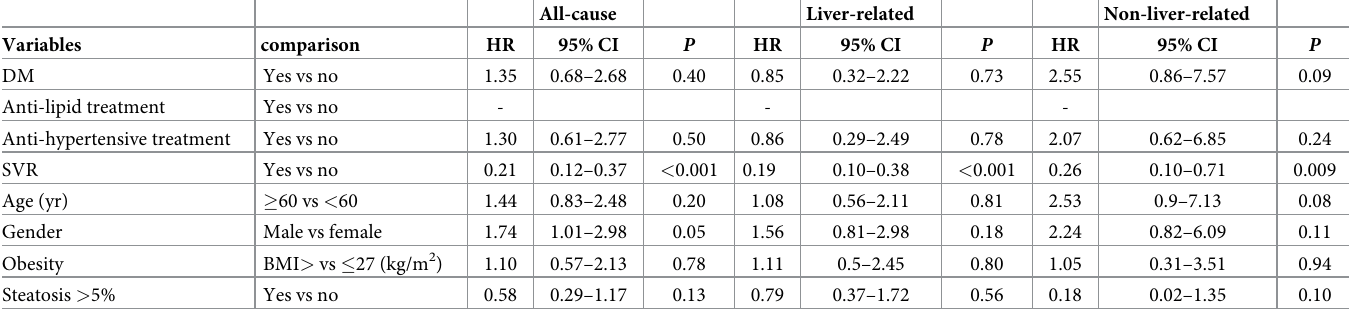
Table 6. Features Associated With Mortality in Advanced Fibrotic Patients (fibrosis score 3–4) (N = 619) According to Cox Proportional Hazards Model:Results of Multivariate Analyses.